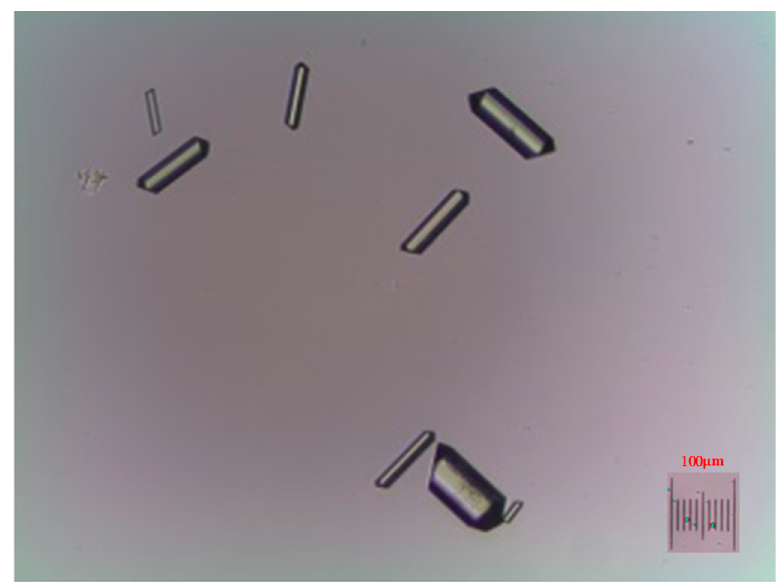
Figure 3. The photograph of the needle-like α -form L-glycine crystals in solution taken in the photomicroscopic experiment at S = 1.12 and 303.15 K.